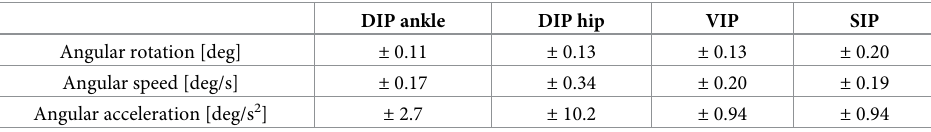
Table 4. Range of variation. DIP ankle DIP hip VIP SIP Angular rotation [deg] ± 0.11 ± 0.13 ± 0.13 ±